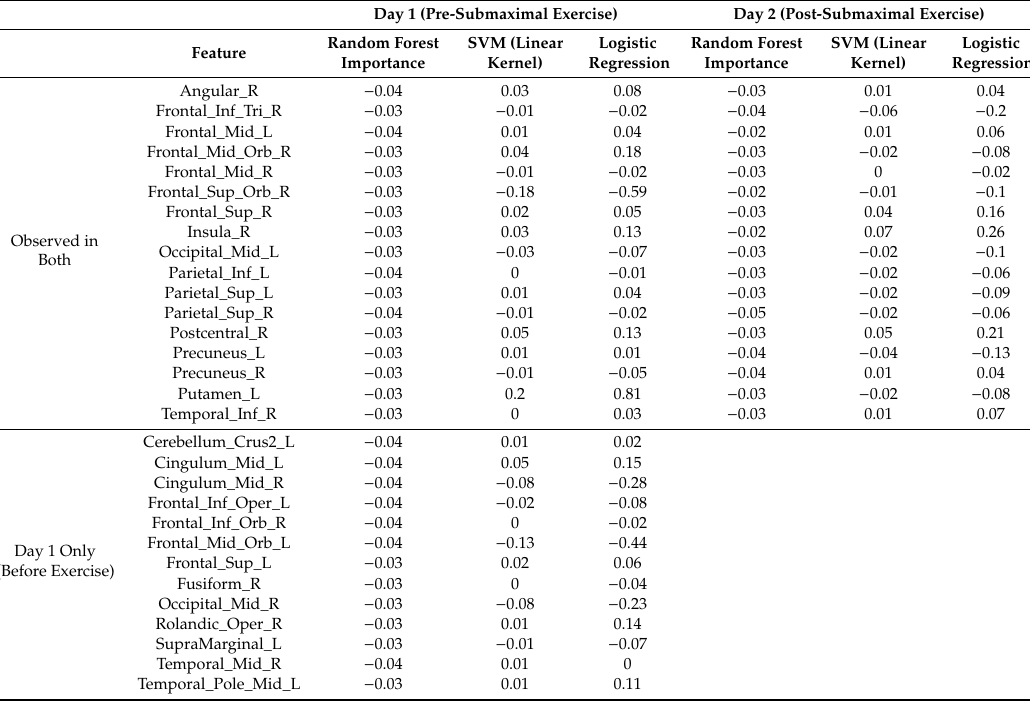
Table 2. Features selected across Bucket of Models and corresponding importance metrics as determined by Random Forest, and coefficients as determined by a Linear Support Vector Machine (SVM) kernel and Logistic Regression. Each of these AAL regions was selected by one or both of the respective Day 1 or Day 2 models based on the training set and validated to achieve the importance metric on the testing set.